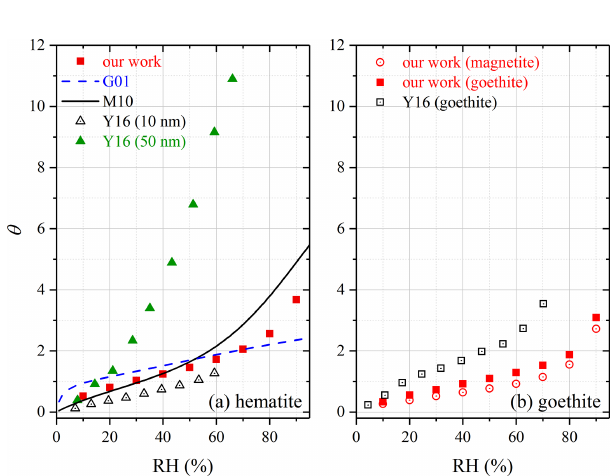
et al., 2012a) and QCM (Hatch et al., 2008; Schuttlefield, 2008; Ye¸silba¸s and Boily, 2016). Hatch et al. (2008) and Ma et al. (2012a) reported m w /m 0 as a function of RH.